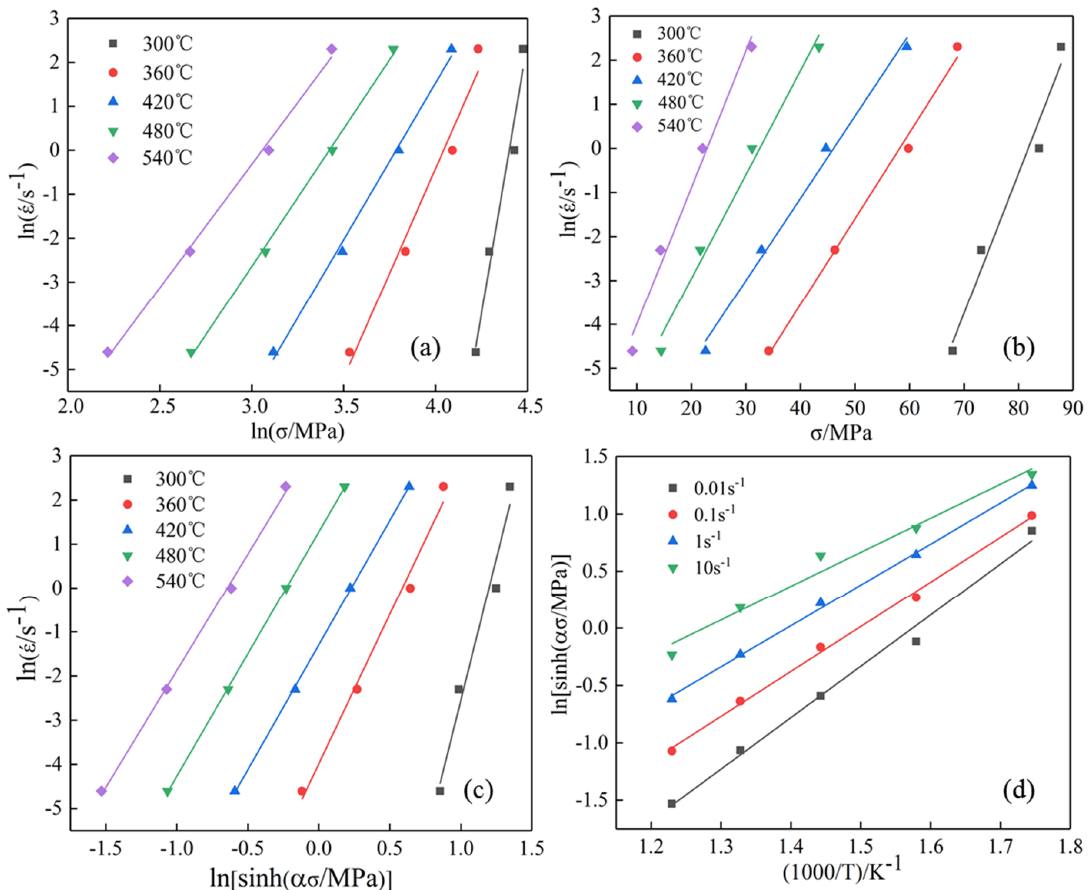
. ε . ε . ε . ε - ln σ ; ( b ) ln - σ ; ( c ) ln - ln [ sinh ( ασ )]; ( d ) ln -1 / T .